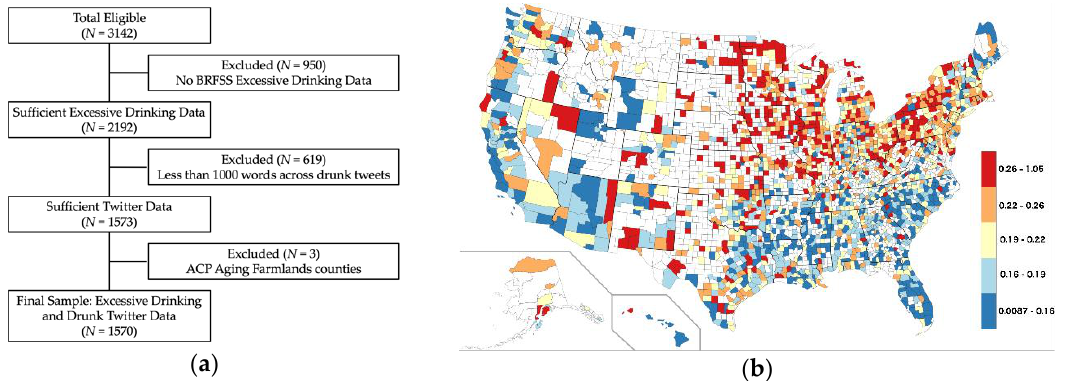
Figure 1. Data description: ( a ) inclusion criteria for this study; ( b ) map of drunk tweet frequency (quintiles, red = high; blue = low).